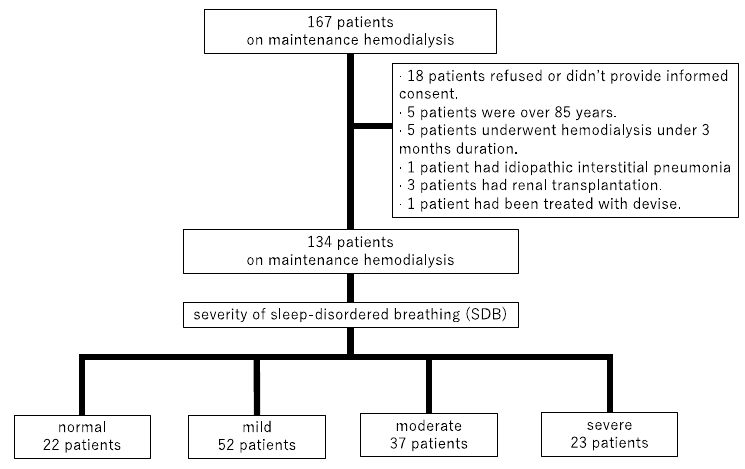
Figure 1. Patient selection flow chart.